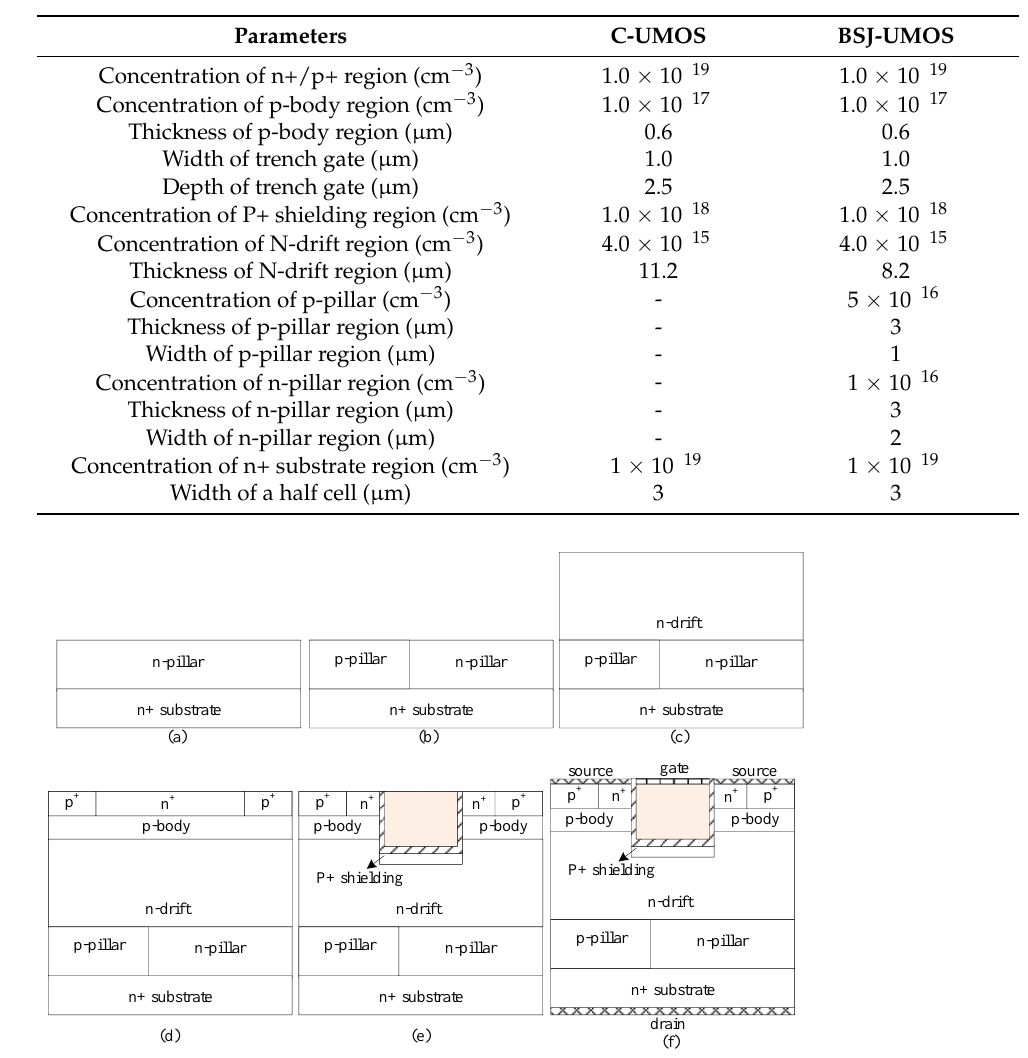
Table 1. Structural parameters of the simulated devices.